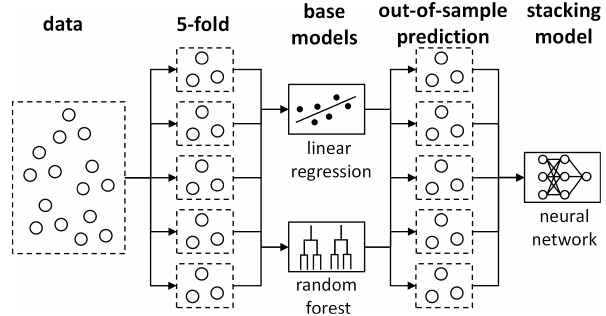
Figure 3. Illustration of a stacking machine learning model for pre- cipitation